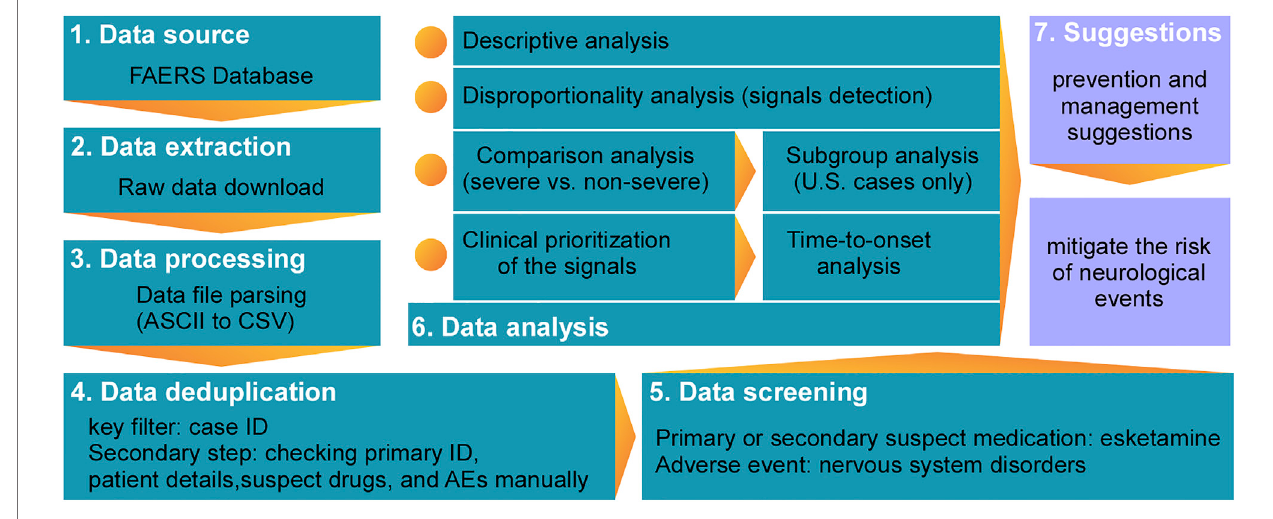
FIGURE 1 | Multi-step process of data extraction, processing, and